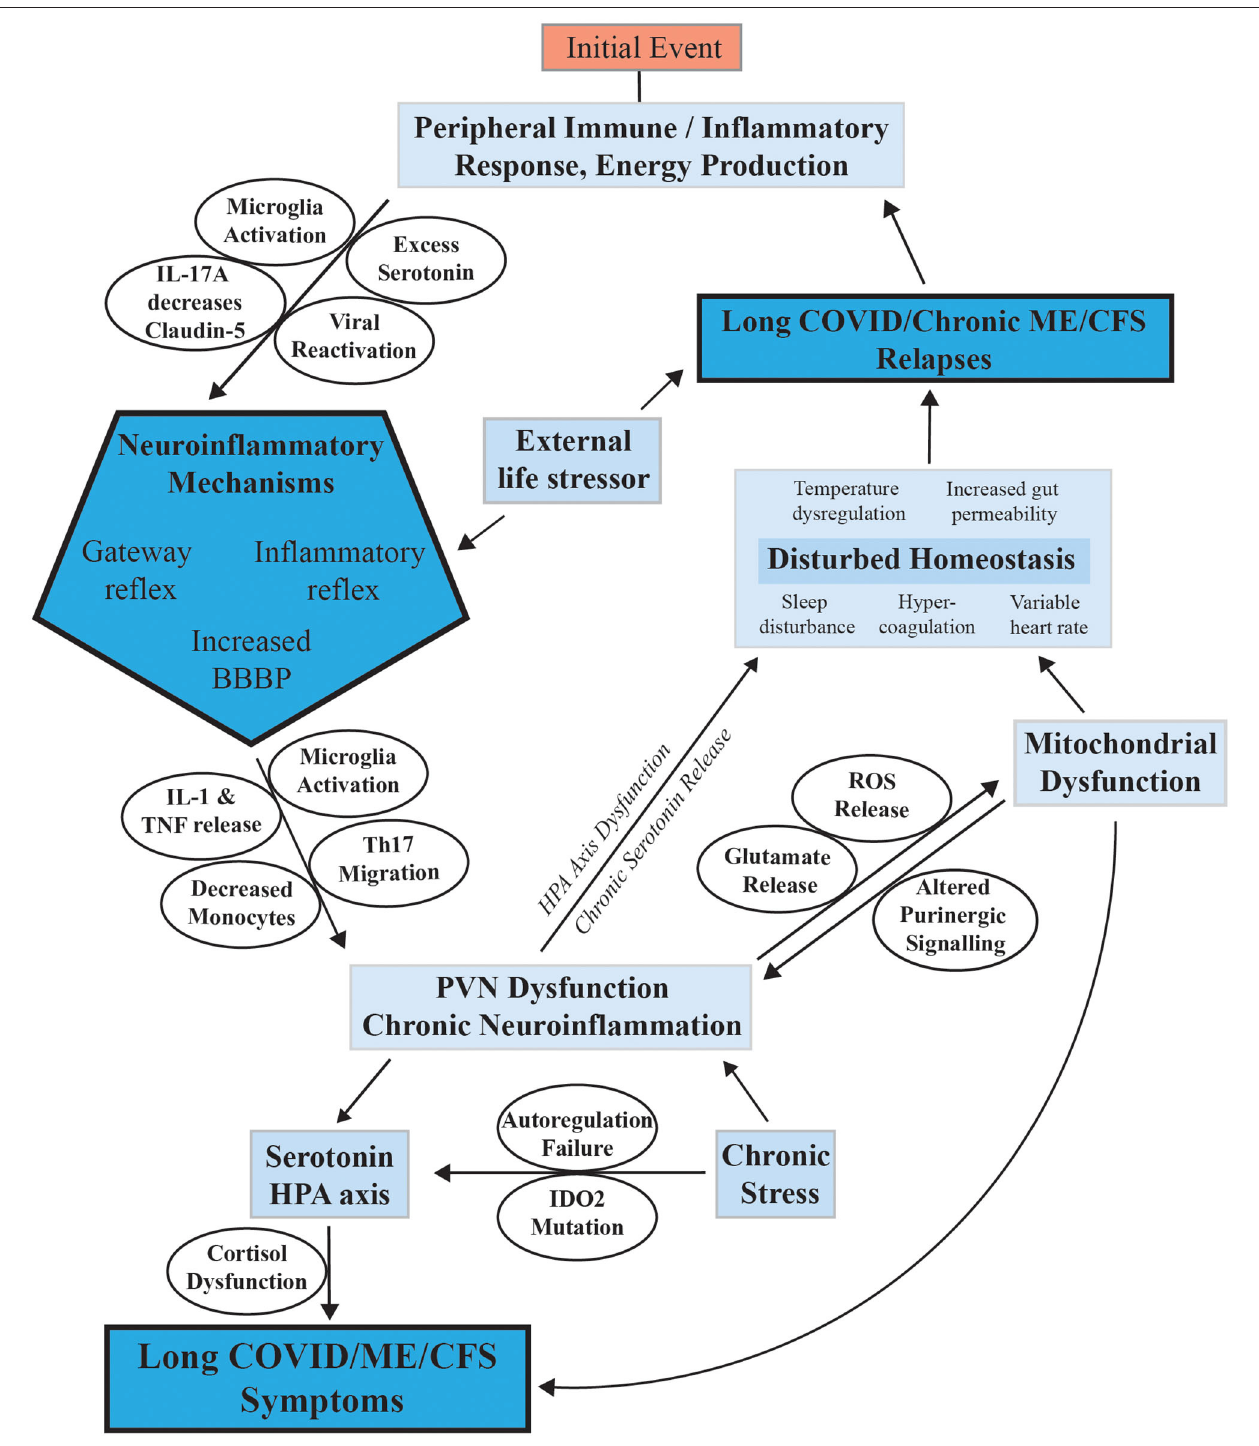
FIGURE 4 | Mechanisms proposed to facilitate the onset of ME/CFS and its progression to a chronic sustained illness with relapse/partial recovery phases. This figure summarizes the mechanisms discussed in the text proposed to have a possible function in sustaining ME/CFS and facilitating relapses.